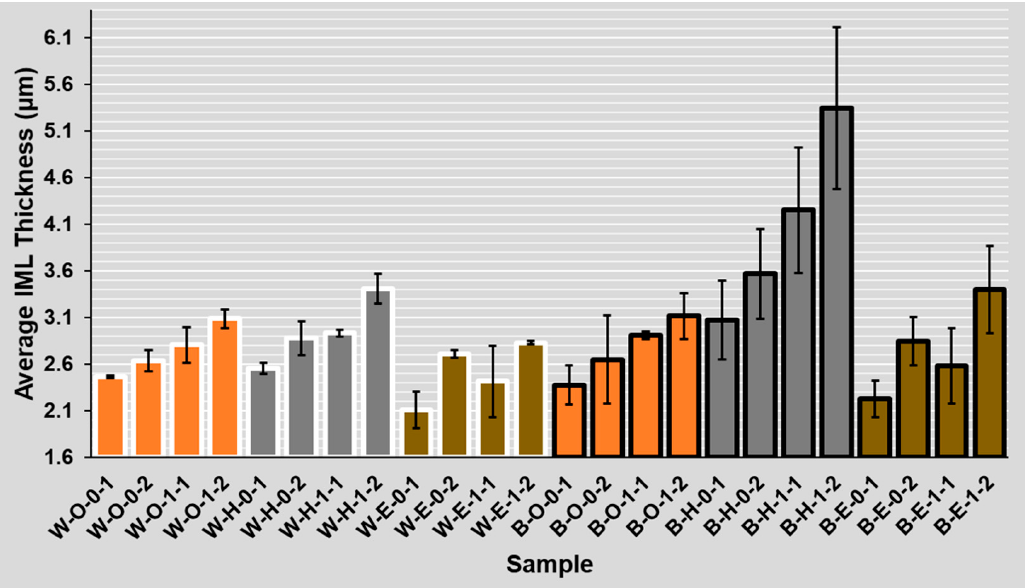
Figure 5. Average IML thickness for various combinations ( B lack/ W hite)—( O SP, H ASL, E NIG)—(ROL 0 , ROL 1 )—( 1 , 2 reflows).